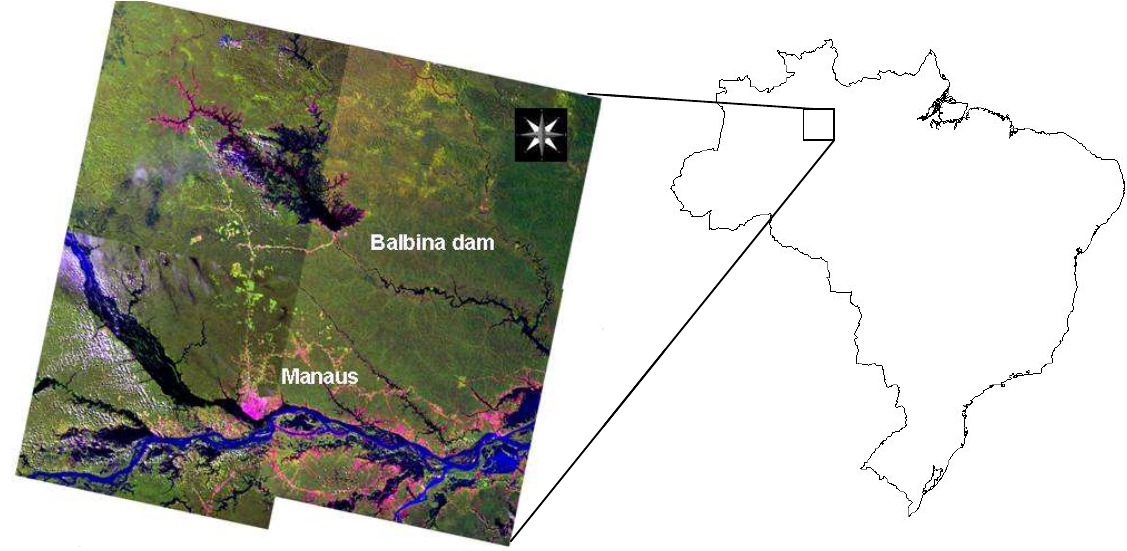
Fig. 1. Landsat image of the sampling site area. The city of Manaus (population 1700000) is shown in the low central portion of the figure. Balbina is located about 200km North from Manaus in a preserved area free of deforestation and under influence of natural emissions of gases and aerosols.